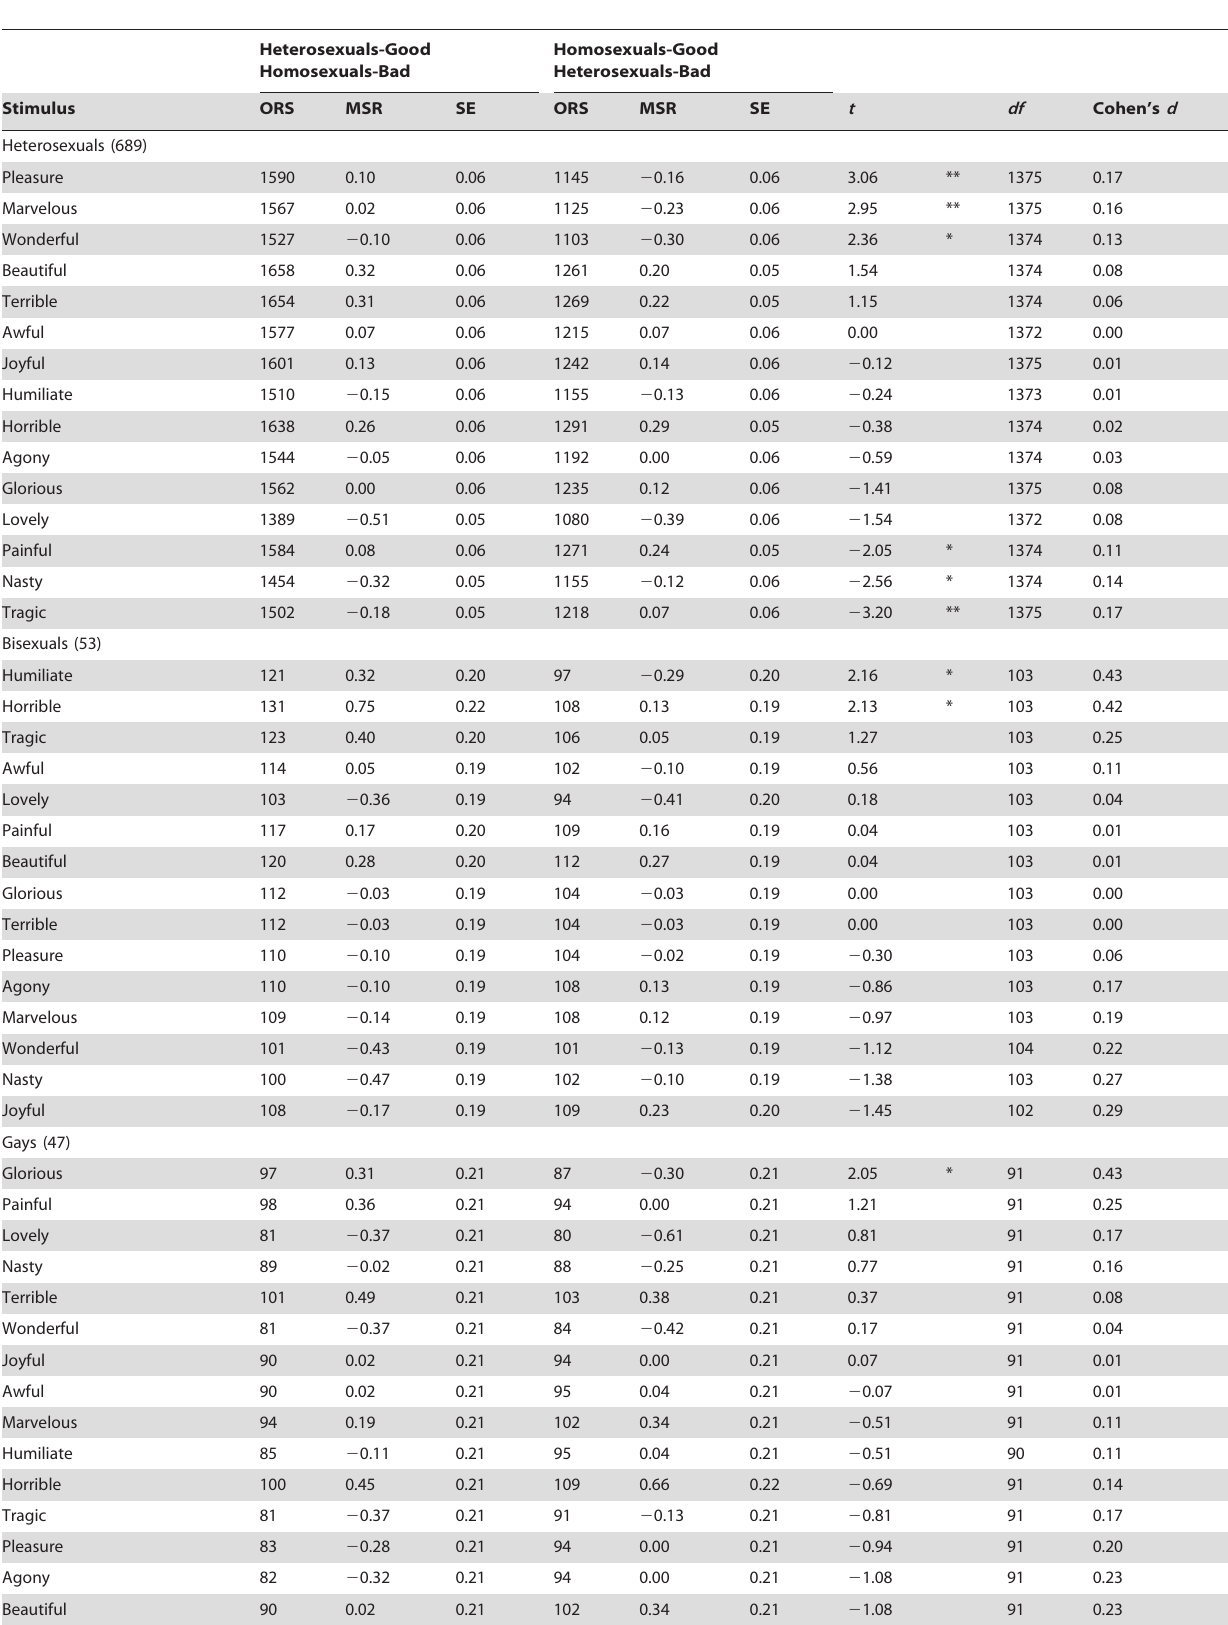
Table 1. Speed of categorization of the stimuli in the two associative conditions for respondents of each sexual orientation.